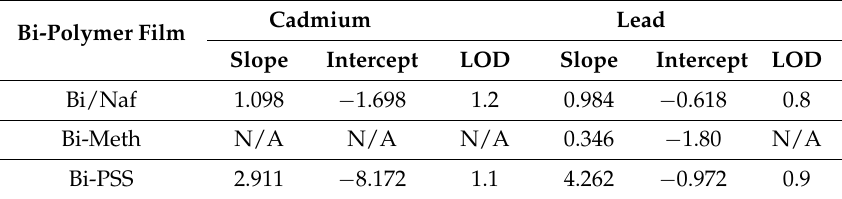
Table 2. Comparison of the calibration linear best fit parameters for cadmium and lead analysis as a function of the polymer used for casting. Experimental conditions: [Cd 2+ ] additions = 25 µ g/L; [Pb 2+ ] additions = 25 µ g/L; 60-s stripping; differential pulse